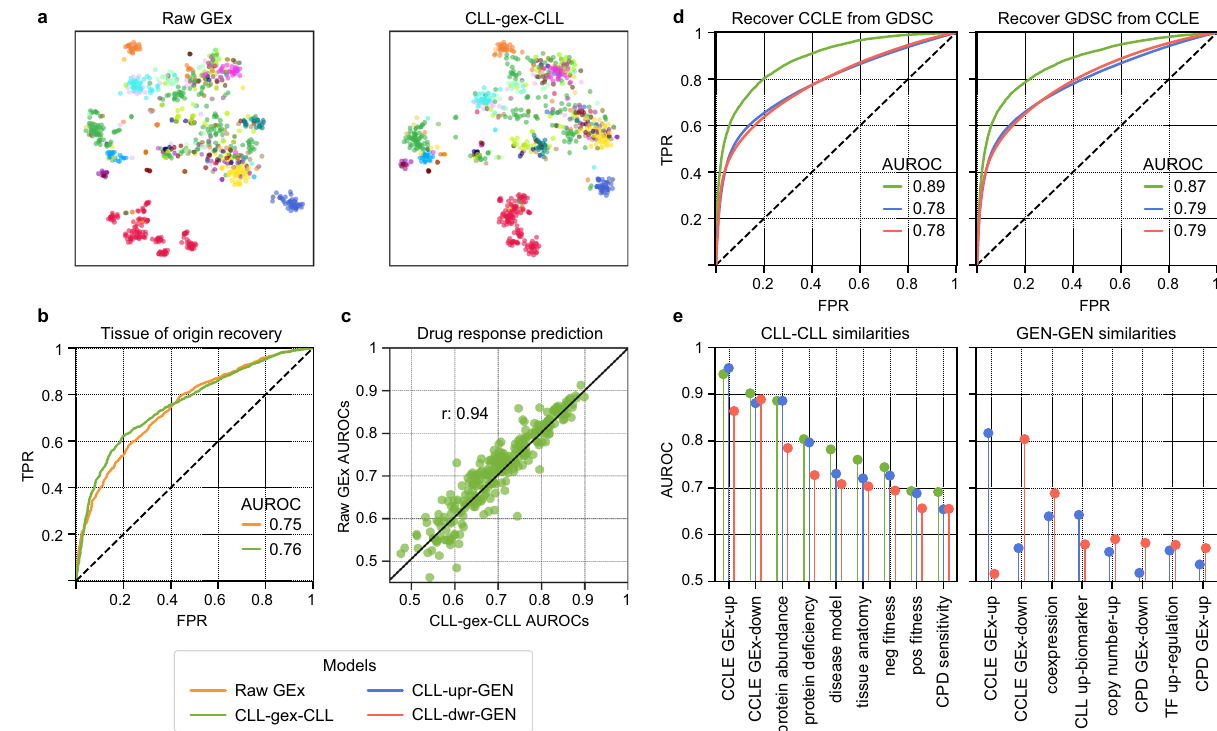
Fig.5|Analysisofgeneexpression(GEx)embeddings.a 2Dprojectionoftheraw GEx (left) and the corresponding Bioteque ‘ cell has similar gex cell ’ (CLL-gex-CLL) embedding (right). Each dot corresponds to one cell line and is coloured by tissue oforigin. b TissuerecoverybytherawGExandtheCLL-gex-CLLembedding. c Drug response prediction performance (AUROC) for each drug in the GDSC resource from models trained with either the raw GEx (y-axis) or the CLL-gex-CLL